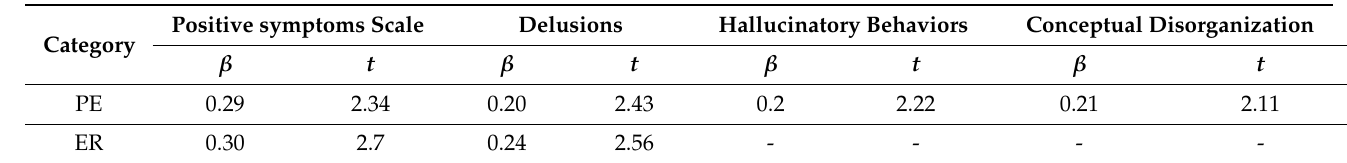
Table 5. Multiple regression analyses of index of significant changes in symptoms in patients with schizophrenia *.